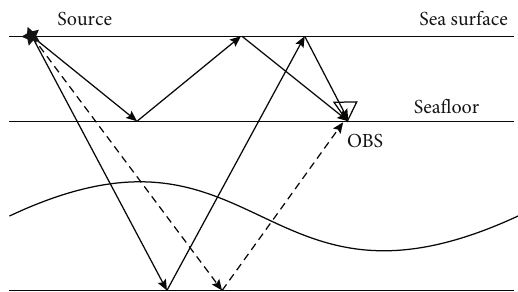
Figure 8: Schematic diagram of wave propagation. The dotted lines indicate the ray paths of upgoing primary waves while the solid lines indicate the ray paths of downgoing multiple waves. For clarity, the ray path of direct wave is not